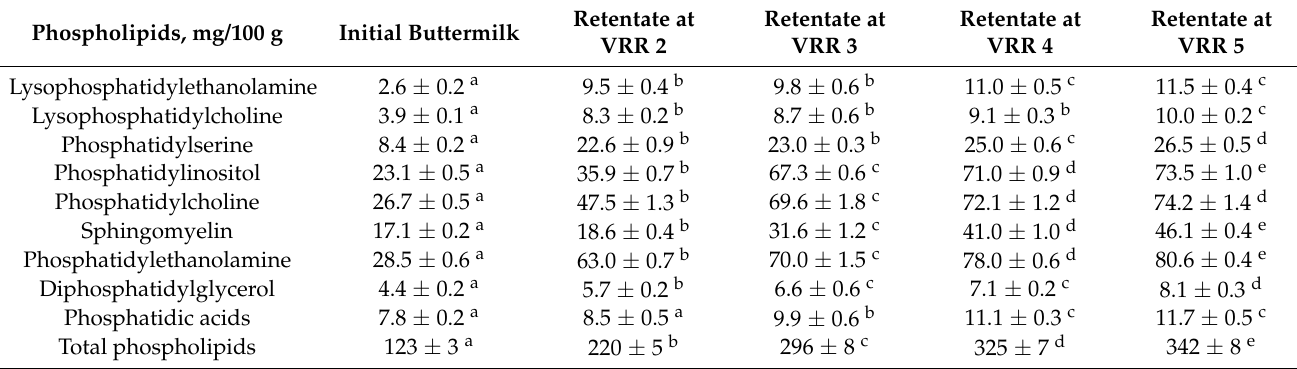
Table 4. Phospholipid composition of buttermilk